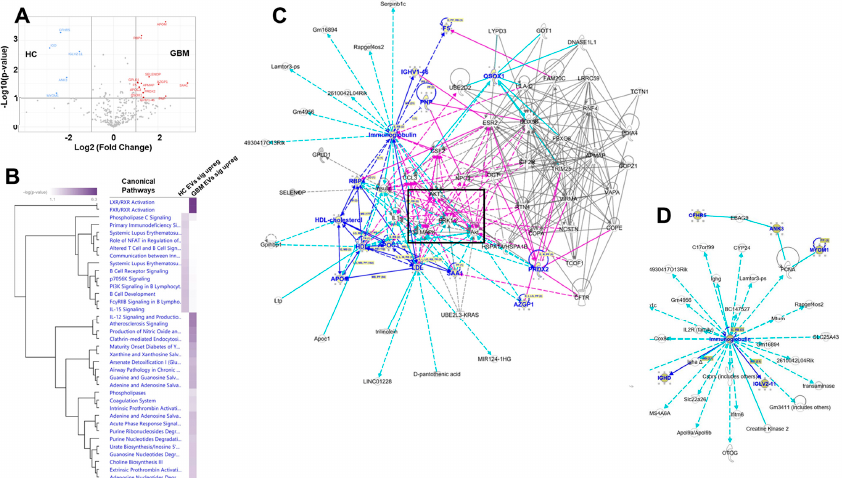
Figure 7. Differential protein content between HC and GBM plasma EV proteomes, and IPA readouts using only those proteins. ( A ). Volcano graph showing significantly different protein con- tent comparing HC plasma EVs (left side, blue designations) and GBM plasma EVs (right side, red designations. ( B ). Comparison analysis of the significantly different proteins (HC plasma EV pro- teins left column; GBM plasma EV proteins right column). Shown are all the significant canonical pathways rendered in hierarchical clustering. ( C ). Merge of the two interactomes from network analysis of significantly expressed GBM plasma EV proteins; black box surrounds signaling nodes of AKT, ERK1/2, and p38MAPK. Network names: (1) “Lipid Metabolism, Molecular Transport, Small Molecule Biochemistry”; score = 33; 11 focus molecules; (2) “Infectious Diseases, Organismal Injury and Abnormalities, Protein Synthesis”; score = 4; 2 focus molecules. ( D ). Sole network from significantly expressed HC plasma EV proteins. Network name: “Auditory Disease, Hereditary Dis- order, Neurologic Disease”; score = 15; 5 focus molecules. For ( C , D ), proteins identified in the da- tasets are listed in blue color.